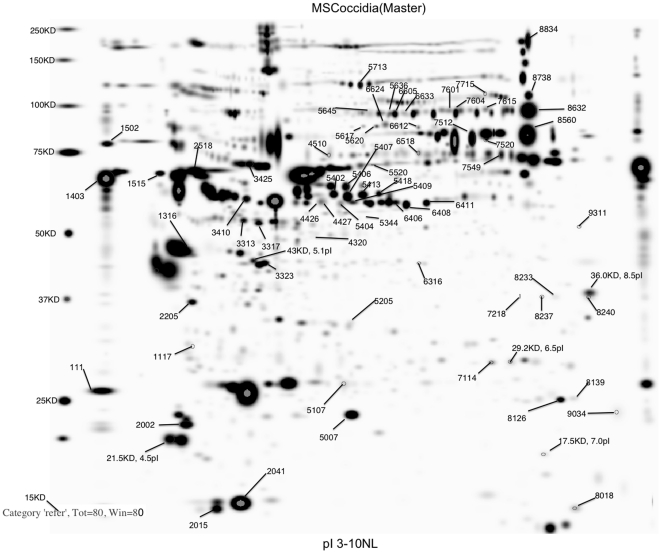
Master image of gel stained with Flamingo™ fluorescent stain following 2-dimensional gel electrophoresis of chicken serum protein.The first dimension was carried out using pH 3–10 immobilized pH gradient strips and the second dimension was performed using 8–16% acrylamide gels. Annotated spots are those showing a significant effect of coccidia infection and/or genetic line×coccidia infection interaction at P<0.001 (Table 2).